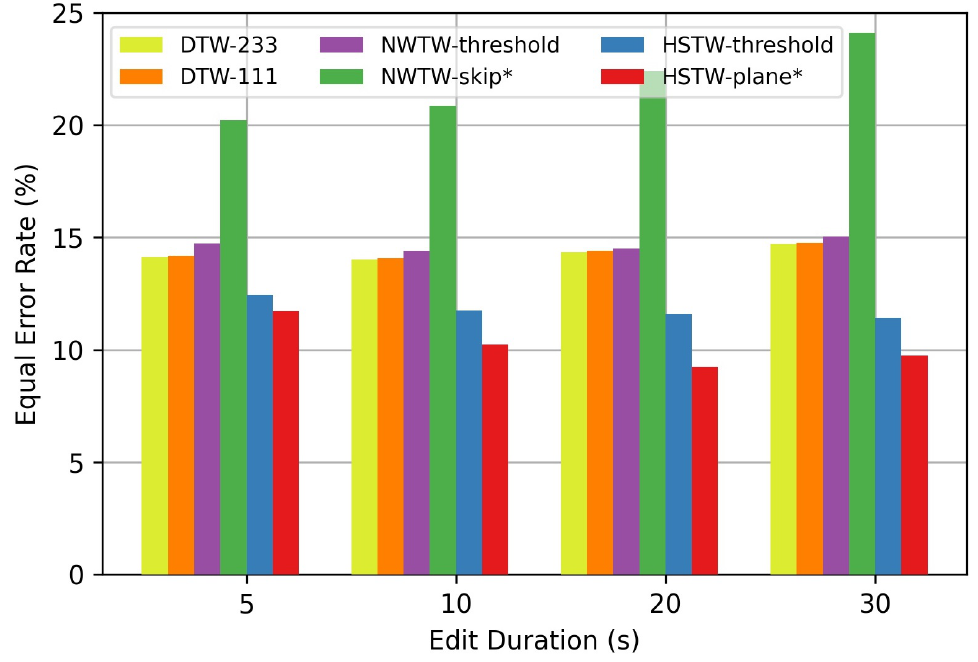
Figure 4. Results on the music synchronization task with non-matching regions. Bars indicate the equal error rate for classifying audio frames as matching vs. non-matching. For systems that are not threshold-based (indicated with ∗ ), bars indicate the mean values of the false positive and false negative